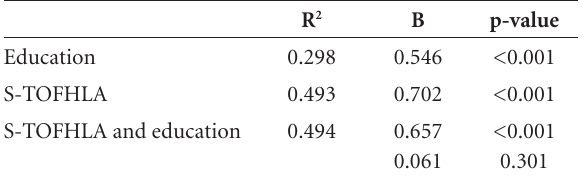
Table 2. Correlations between MMSE, TOFHLA, and schooling. Table 3. Linear regression with MMSE scores as dependent